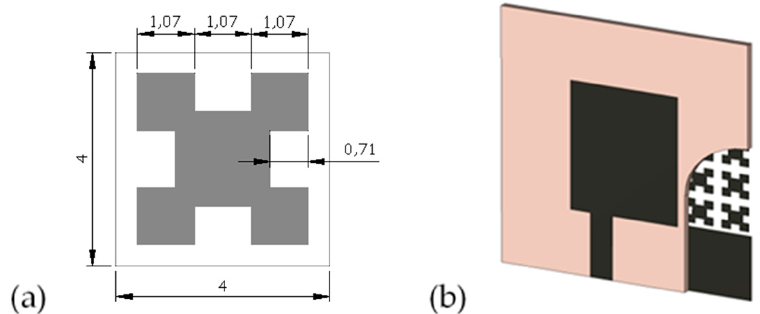
Figure 4. ( a ) The Minkowski island fractal based elementary unit cell of the antenna (dimensions are in mm); ( b ) geometry of the antenna with Minkowski fractal on the lower layer.